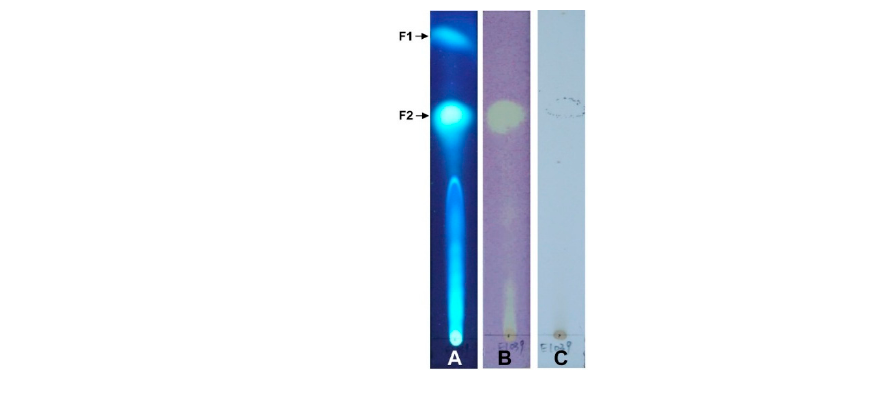
Figure 4. Bioautographic TLC assay of ELF000039 crude extract. ( A ) Crude extract developed on a TLC plate under UV light; ( B ) TLC plate sprayed with DPPH methanol solution under visible light; ( C ) TLC plate sprayed with 10% H 2 SO 4 under visible light.